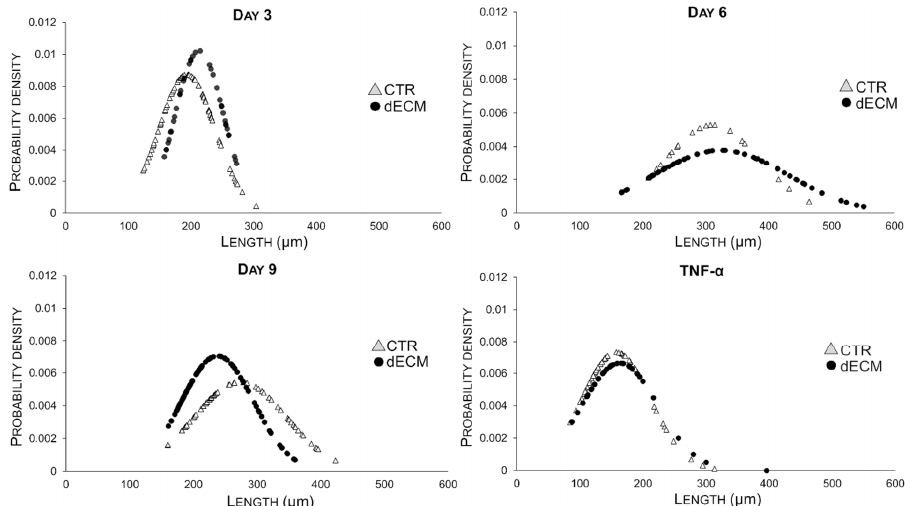
Figure 5. Time course of morphological changes (length) of C2C12 derived myotubes grown for 3, 6, and 9 days on plastic plates either uncoated or coated with dECM. The data are expressed as Gaussian curves with n ≥ 70. Measures were taken from bright filed images (20× magnification).